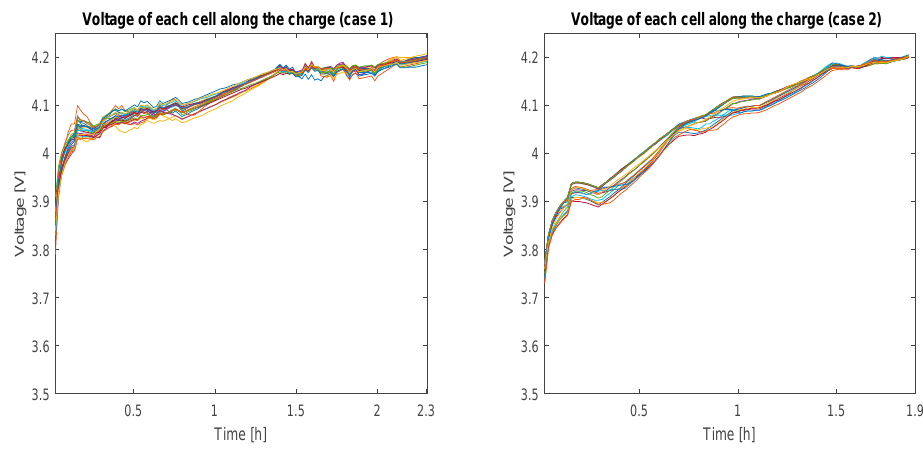
Figure 19. Voltage profile per cell during charging.